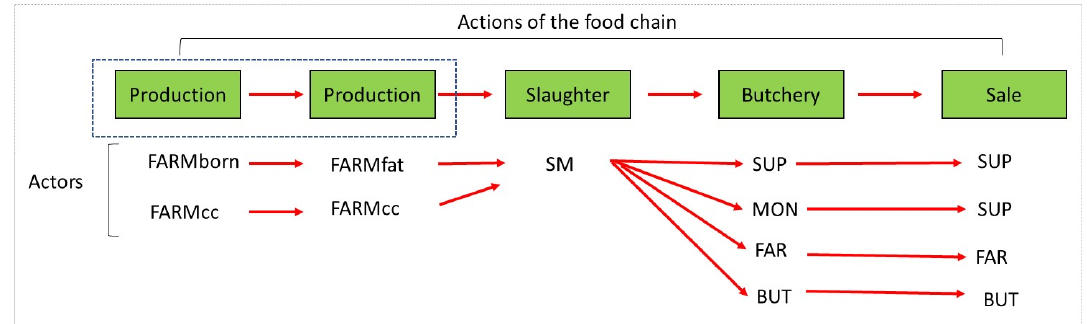
Figure 7. Food value chain detected in 2018. FAR indicates the farms, especially, FARMborn to farms that sells calves; FARMfat to farms that do the fattening of the animals; FARMcc to farms that have the complete cycle of production; SM, the slaughterhouse; SUP, the supermarkets; BUT, the butcheries; and MON refers to a big butchery company.